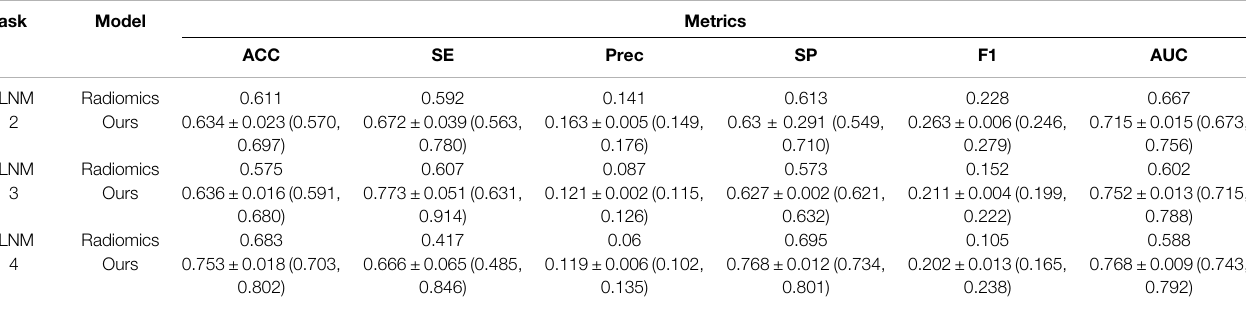
TABLE 4 | Performance of the radiomics model and our model on prediction of the exact number of lymph-node metastases. Task